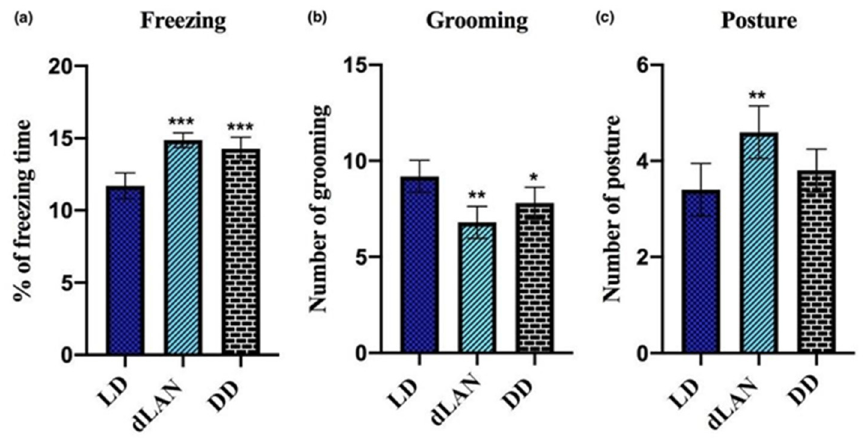
Figure 3. Effect of exposure to dim light at night (dLAN) and complete darkness (DD) on the anxiety-like behavior of mice. ( a ) Percentage of freezing time, ( b ) grooming, and ( c ) posture. Values are represented as mean ± standard deviation ( n = 5). Non-parametric one-way ANOVA with post-hoc Dunnett’s test was employed to match the results between the light/dark (LD) control vs. the dLAN control and DD control. All the data were analyzed with GraphPad Prism-8 software. The statistical values * p < 0.05, ** p < 0.01, and *** p < 0.001 represent a significant difference among the groups.